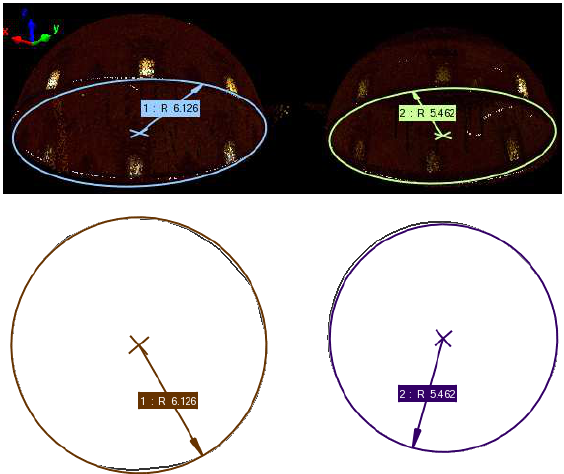
Figure 13. Dimensions of Masjid (left) and Semahane (right) domes (units are meters).